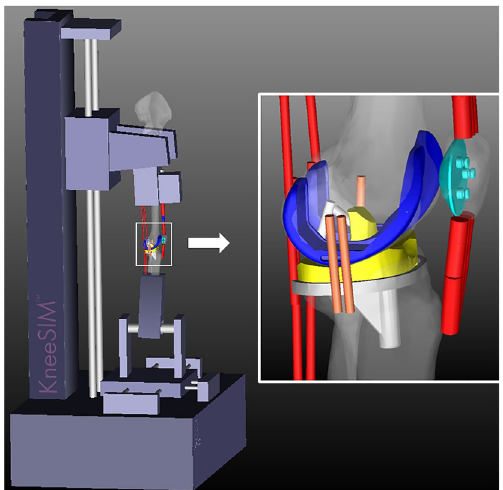
Figure 2. The knee simulator model used in the present study; LifeMOD/KneeSIM